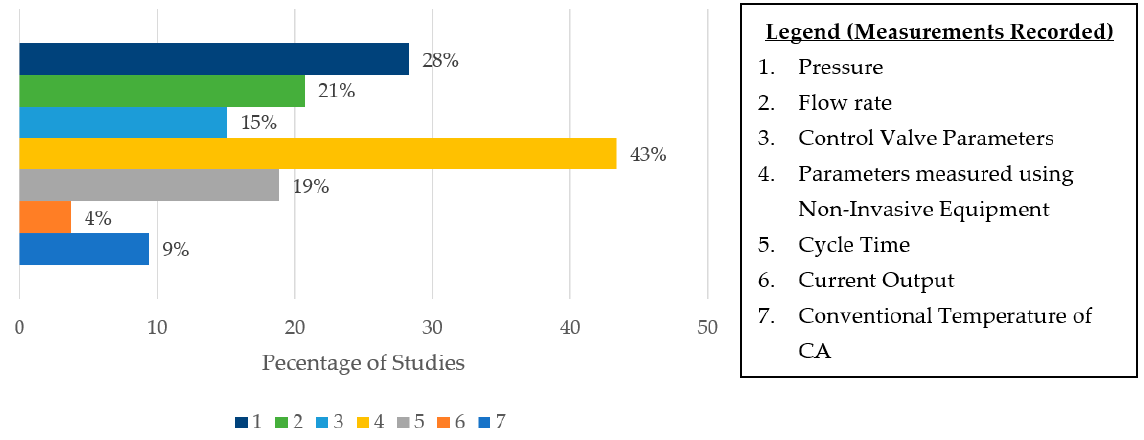
Figure 7. The distribution of the measurements recorded in the reviewed studies.